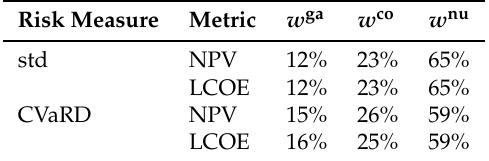
Table 8. The composition of minimum risk portfolios in the 40-year portfolio selection problem. The three-asset case.